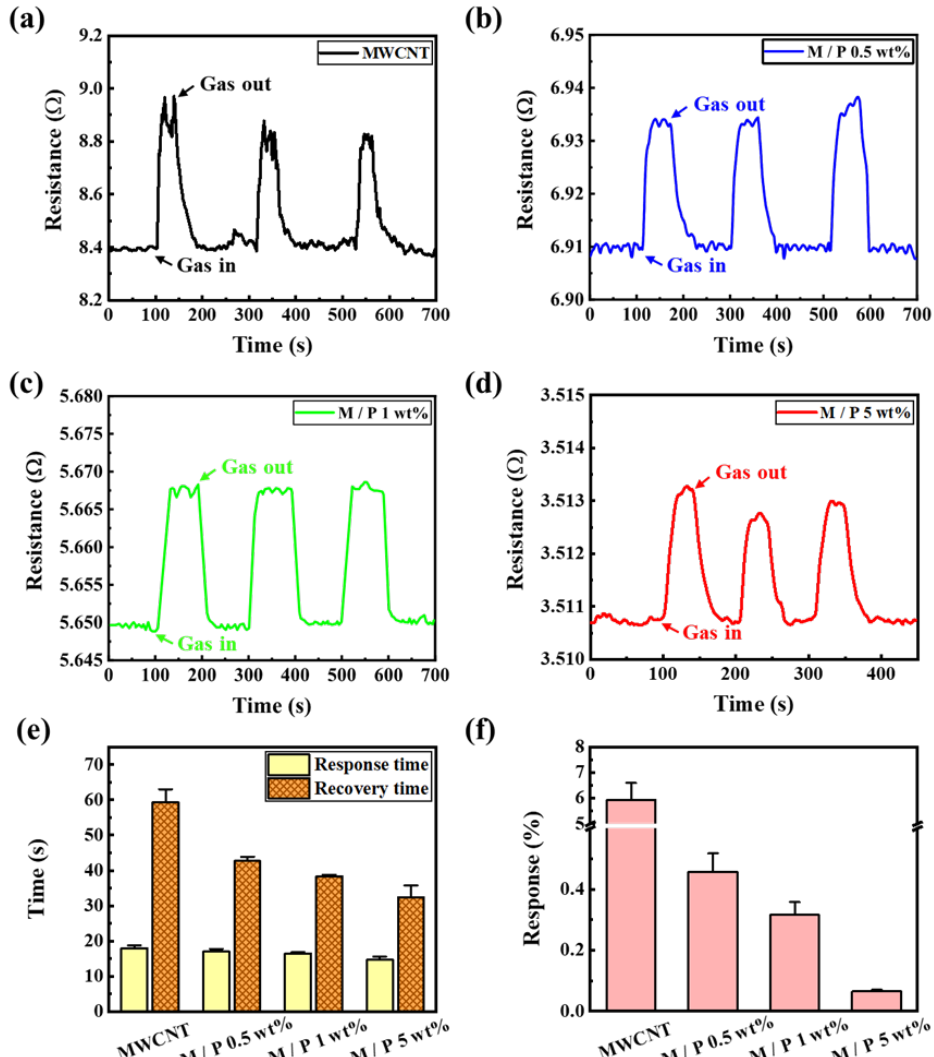
Figure 5. Response curves to 400 ppm of ethanol gas for ( a ) pristine MWCNTs and ( b ) 0.5 wt% PEDOT:PSS-MWCNTs. ( c ) 1 wt% PEDOT:PSS-MWCNTs. ( d ) 5 wt% PEDOT:PSS-MWCNTs. ( e